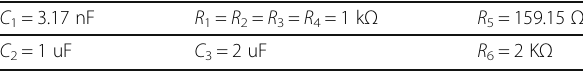
Table 3 Component values of the designed band-stop filter